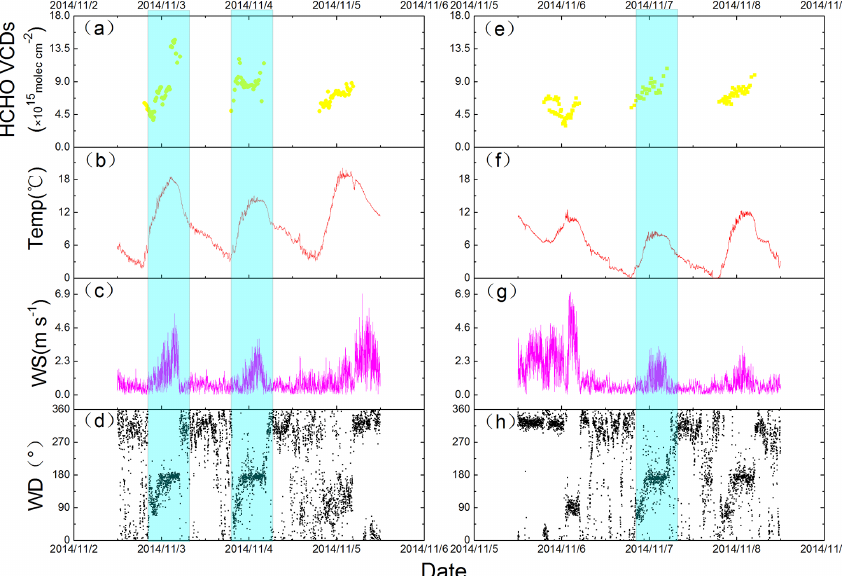
Figure 7. Time series of HCHO VCDs (moleculescm − 2 ) and meteorological parameters (ambient temperature, ◦ C; relative humidity, %; wind direction, ◦ ; and wind speed, ms − 1 ) measured at the supersite in the two periods of 3 to 5 November 2014 (a–d) and 6 to 8 Novem- ber 2014 (e–h) .